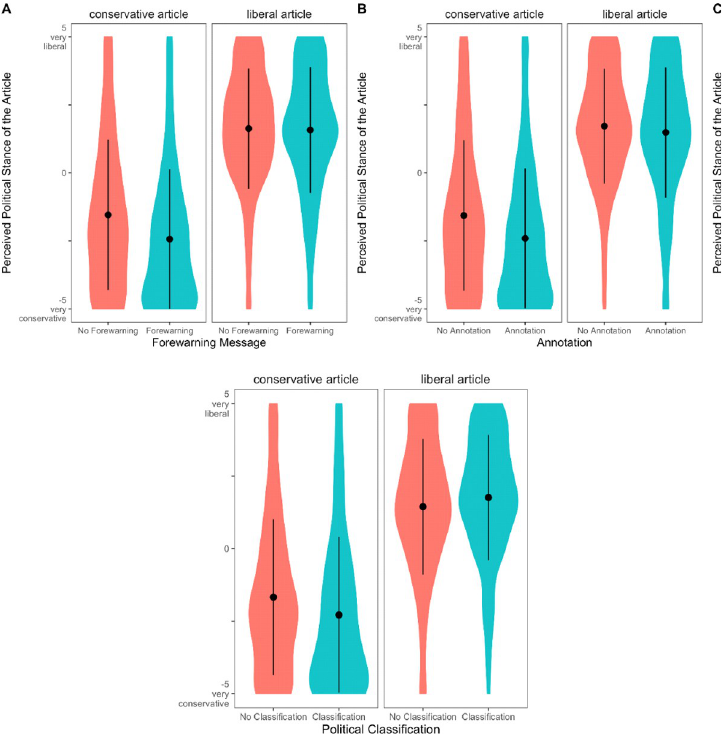
Fig 3. Perceived stance of conservative and liberal articles by intervention conditions. Across all conditions, liberal articles were perceived to be more liberal and conservative articles more conservative. The interventions increased the differences between the two ratings. Dots represent means, and lines are standard deviations.